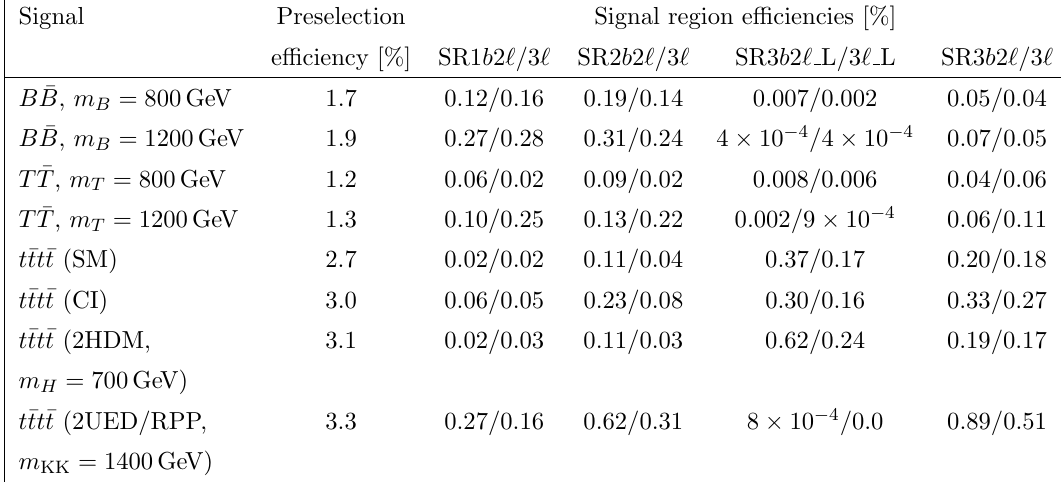
Table 3 . Signal selection and preselection e(cid:14)ciencies for events in various signal models, as esti- mated from MC simulation. VLQs are assumed to decay with the branching ratios expected in the singlet model of ref. [2].